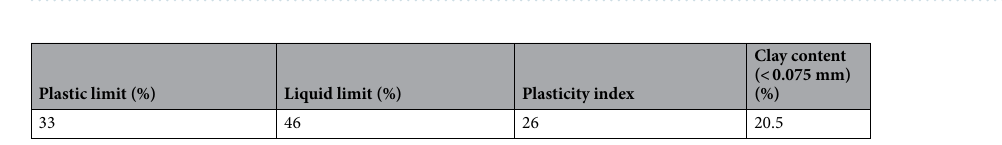
Figure 12. Special soil liquefaction discovered on a rice field at Wangjia Village. The participant included in the study has provided informed consent to publish the image.